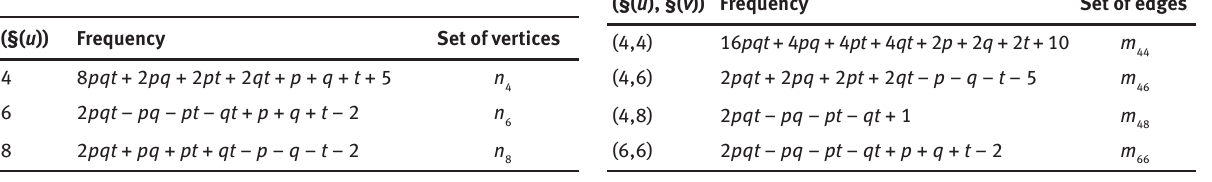
[ p , q , t ] based on degrees of end 2